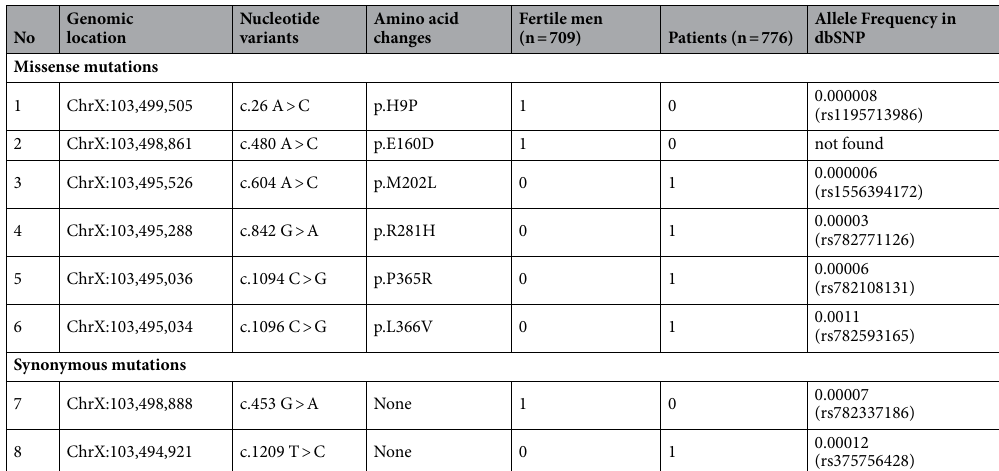
Table 1. Mutations of ESX1 identified in fertile men and patients with NOA.